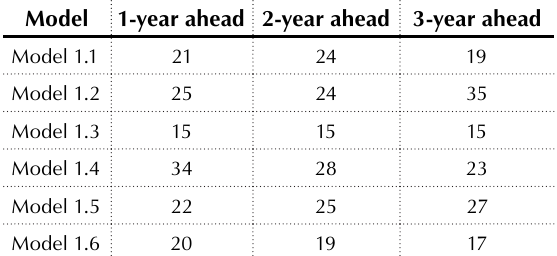
Table 7. Type I errors of logistic regression models (%) Model